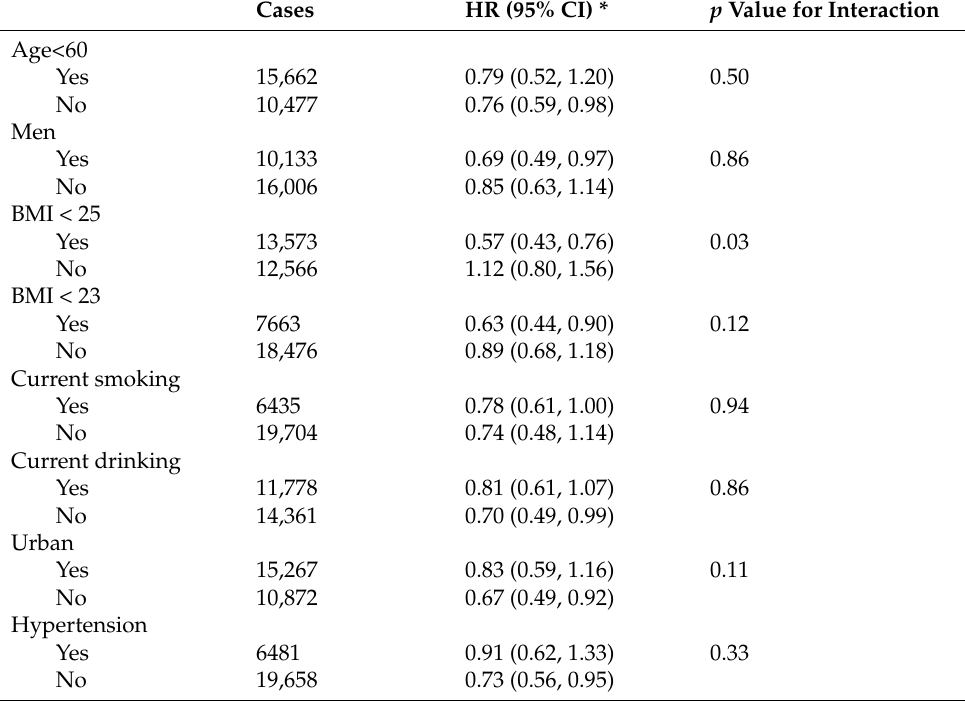
Table 3. Multivariable-adjusted risks for the associations between soy product consumption and cardiovascular mortality by age, sex, body mass index (BMI), smoking status, drinking status, region, and hypertension status among people with type 2 diabetes at